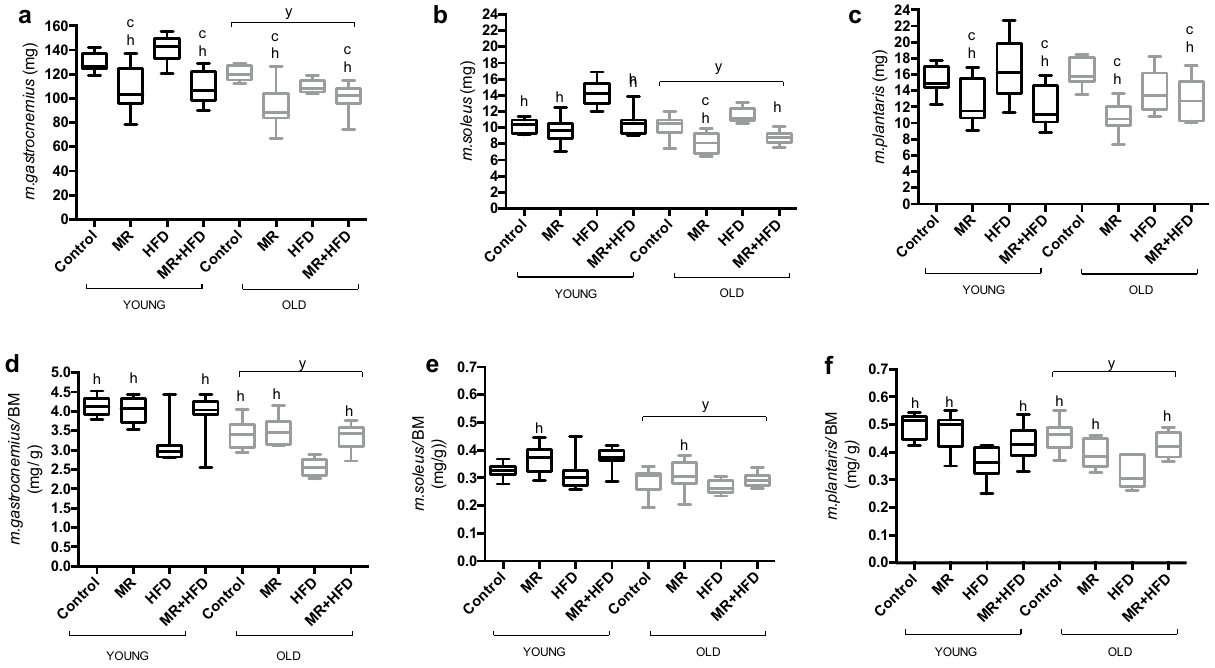
Figure 3. ( a ) m. gastrocnemius, ( b ) m. soleus, ( c ) m. plantaris mass (mg), ( d ) m. gastrocnemius mass per body mass (BM), ( e ) m. soleus mass per body mass and ( f ) m. plantaris mass per body mass (mg/g) from the control leg of young (black boxes) and old (grey boxes) mice fed—control, methionine restricted (MR), high fat diet (HFD) and MR + HFD. y: significantly different from young at p ≤ 0.009. c, h: significantly different from control and HFD respectively at p ≤ 0.026. Data is presented as mean, min,